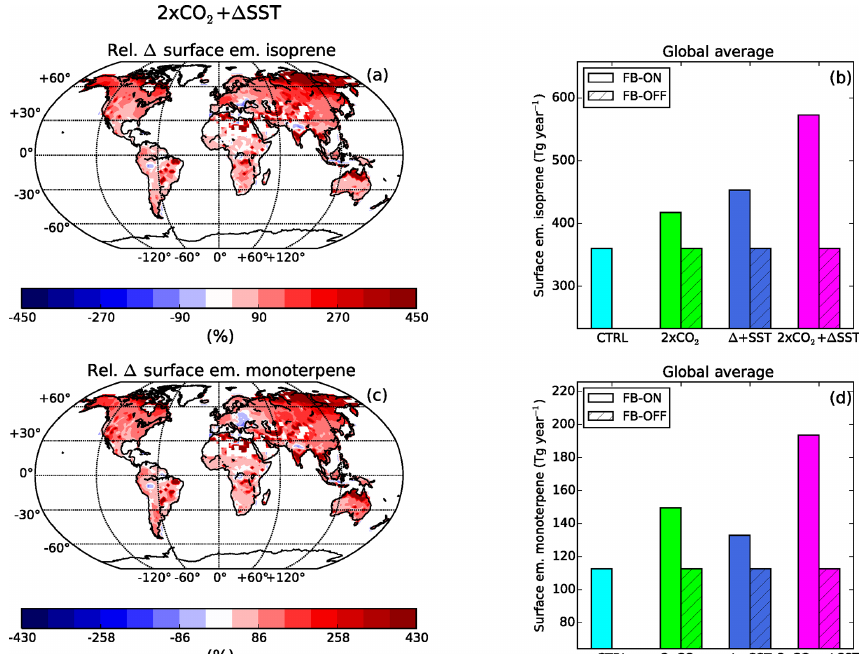
Figure 3. The relative difference between the FB-ON and FB-OFF simulations of the annual average surface emissions of isoprene (a) and monoterpenes (c) for the 2 × CO 2 + (cid:49) SST experiment. The relative difference is defined as the (FB-ON − FB-OFF) / FB-OFF. In the bar plots, the yearly global surface emissions of isoprene (b) and monoterpenes (d) for the CTRL simulation as well as the three experiments (both FB-ON and FB-OFF simulations) are